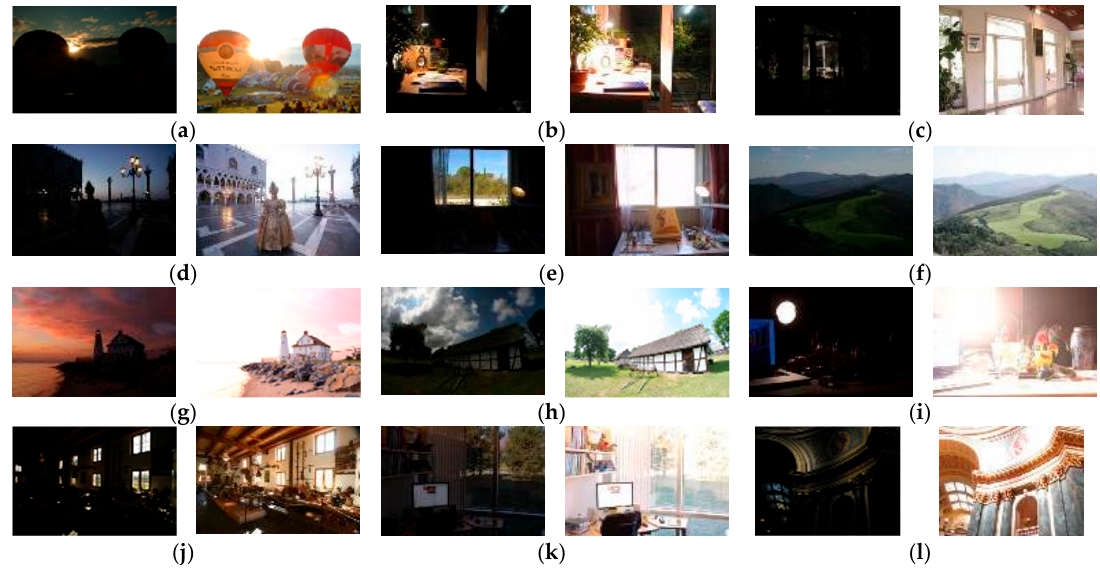
Figure 6. Multi-exposure source image sequences used in the experiments: ( a ) “balloons”, 512 × 339 × 9 (the sequence contains a total of nine images, and the spatial resolution of each is 512 × 339); ( b ) “recorder”, 1024 × 768 × 13; ( c ) “Belgium House”, 512 × 384 × 9; ( d ) “mask”, 1200 × 800 × 3; ( e ) “StudioEV”, 1200 × 800 × 5; ( f ) “landscape”, 512 × 341 × 3; ( g ) “lighthouse”, 512 × 340 × 3; ( h ) “Kluki”, 512 × 341 × 3; ( i ) “desk”, 640 × 427 × 7; ( j ) “farm house”, 512 × 341 × 3; ( k ) “office”, 512 × 340 × 6; and